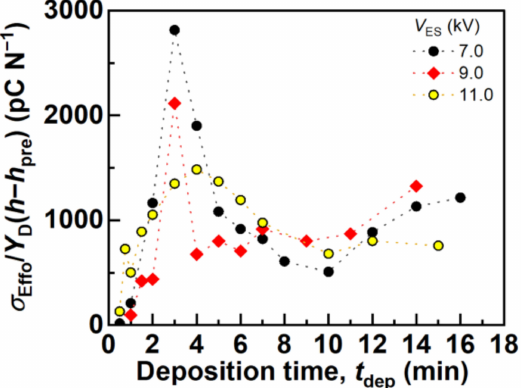
Figure 9. Calculated σ Eff0 / Y D ( h - h pre ) of the fiber mats produced with different t dep and V ES . Here, Y D ( h - h pre ) with P ( h ) = 1 kPa was used for the calculation.